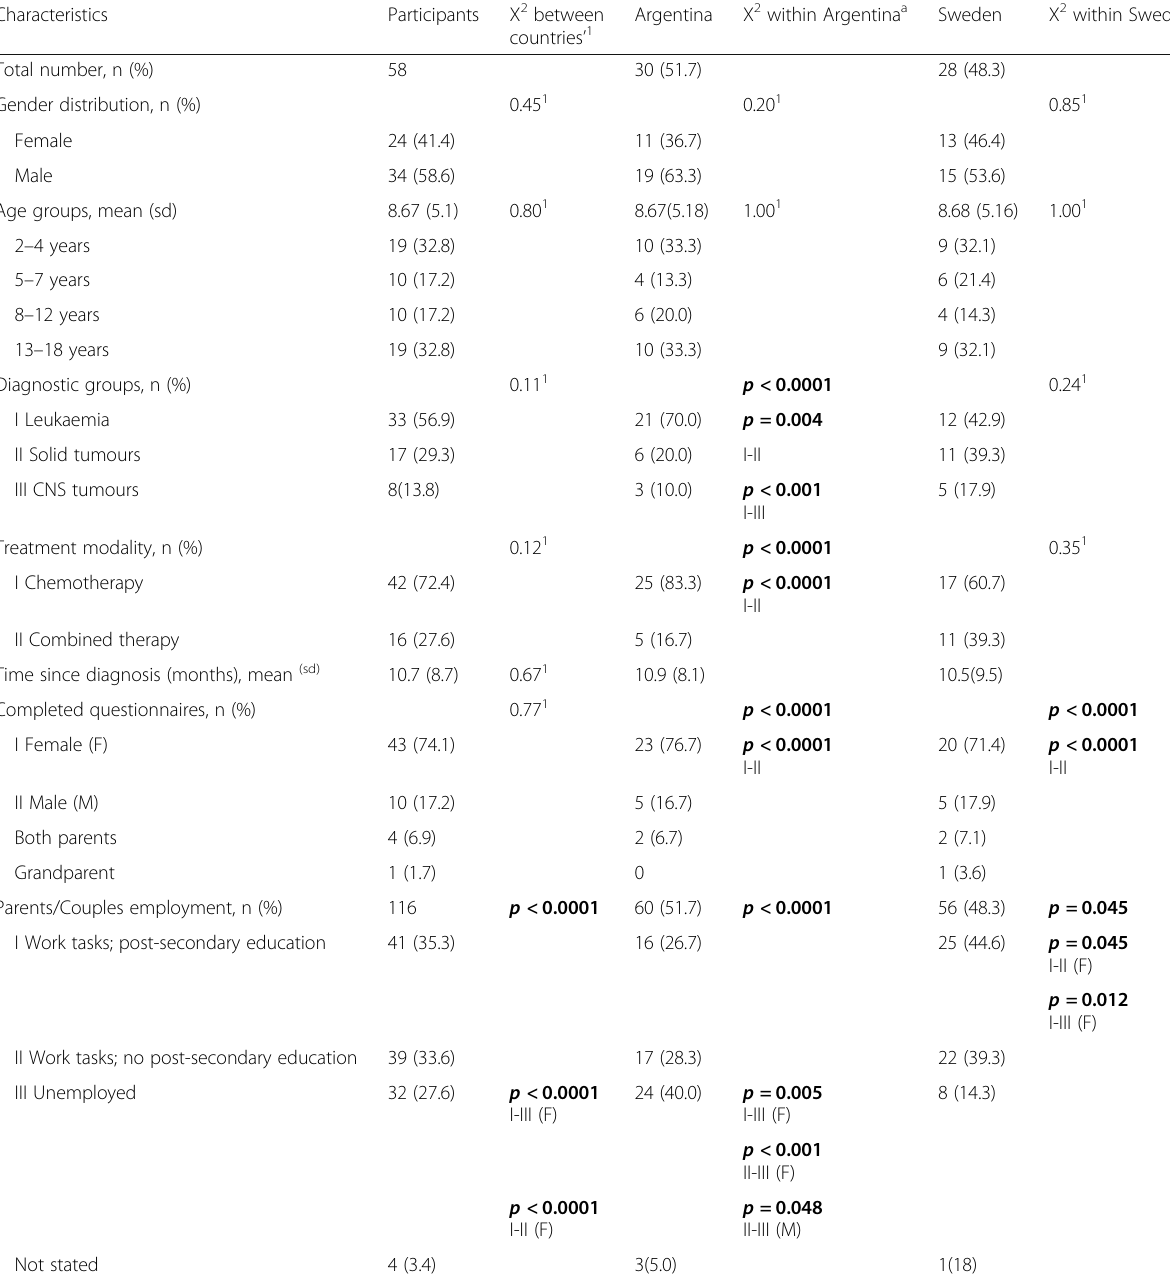
Table 1 Demographic data and clinical characteristics of participating children and parents